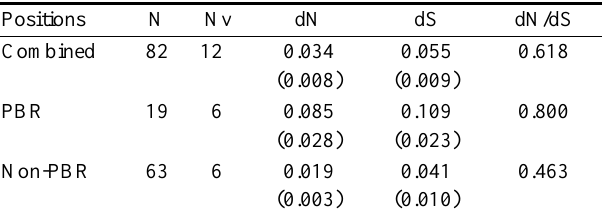
Table 2. The average rates of synonymous substitutions (dS) and